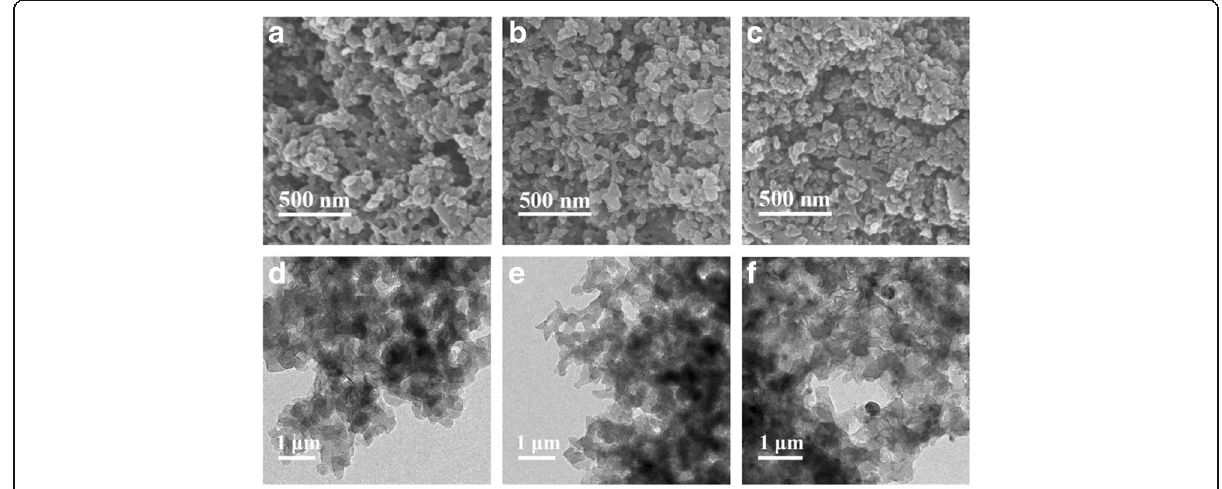
Fig. 1 SEM images of a ACA-500, b ACA-500-S, and c ACA-500-S@PANi; TEM images of d ACA-500, e ACA-500-S, and f ACA-500-S@PANi